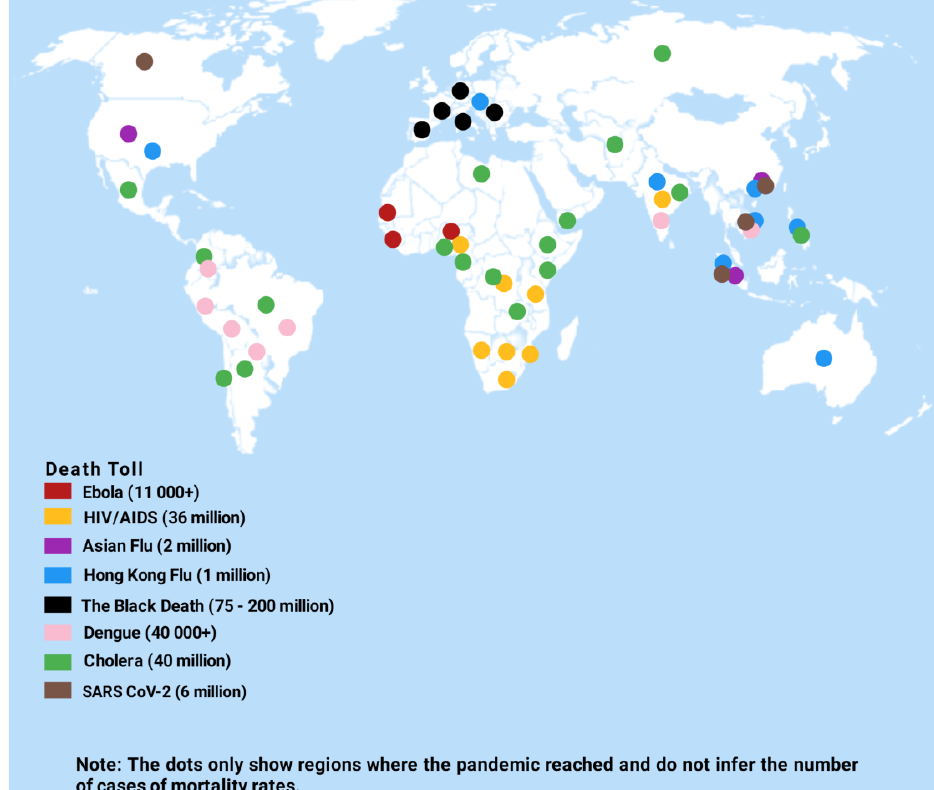
Figure 1. Geographical distribution of zoonosis across different regions.